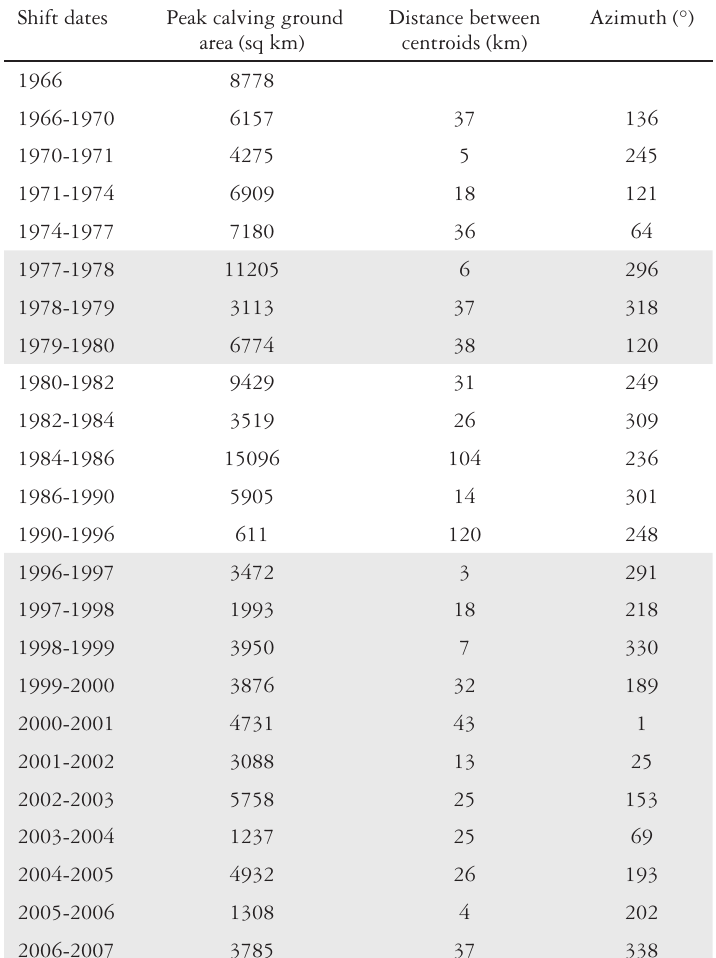
Table 1. Size, distance between centroids, and direction of shift for successive peak calving grounds, determined by satellite collars and peak calving grounds for the Bathurst herd, NU (grey shading denotes consecutive